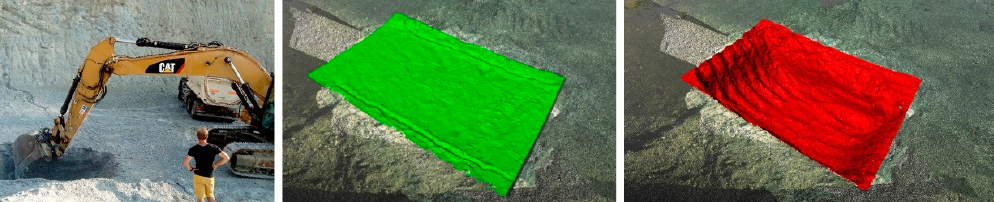
Figure 7. Collection of the large-scale sample—Probe 2. Before excavation—green left, after excavation—red right.